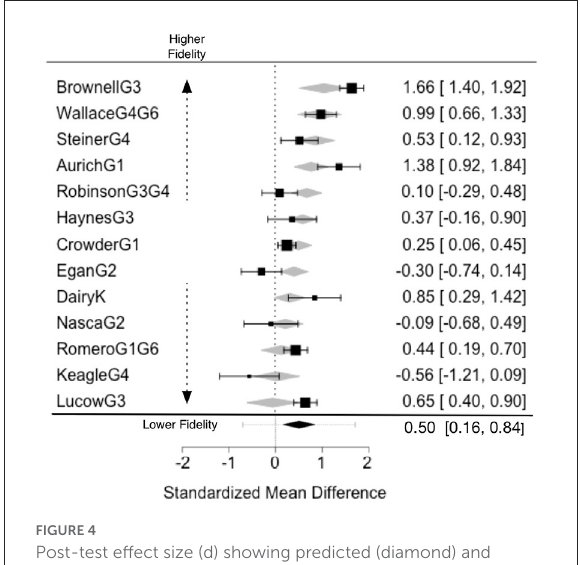
FIGURE4 Post-test effect size (d) showing predicted (diamond) and observed (bar) proficiency outcome effect sizes by experiment in order of fidelity. Prediction interval and summary “diamond” for C.I. for